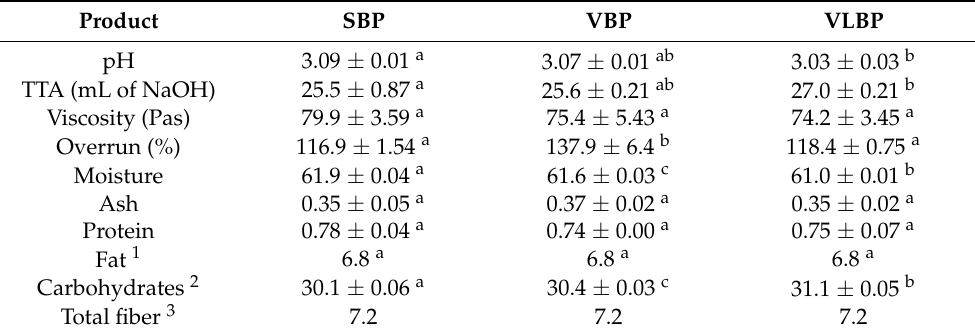
Table 1. pH, TTA (mL of NaOH 10 g − 1 ), viscosity (Pas), overrun (%), and nutritional composition (g 100 g − 1 , fresh matter) (average ± standard deviation (SD)) of frozen blackcurrant